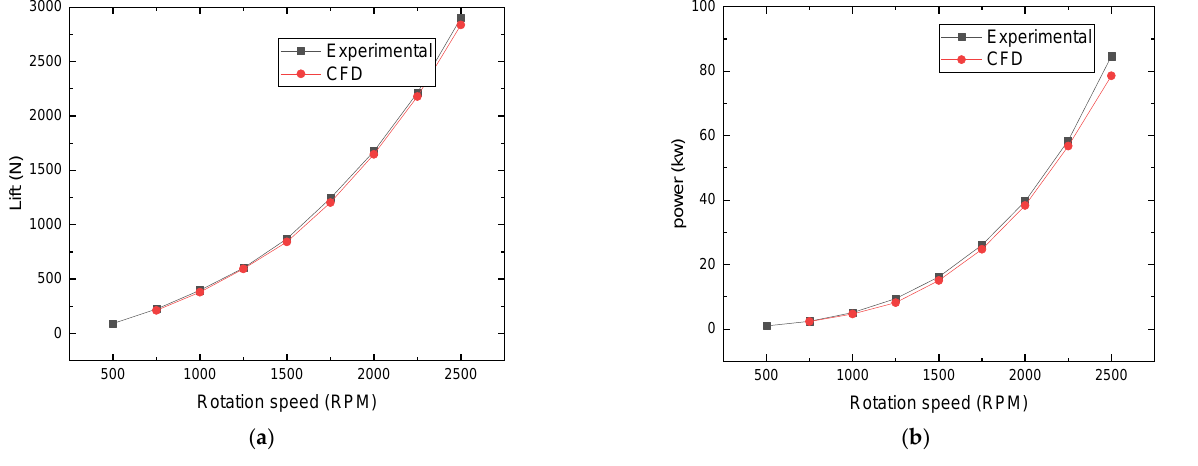
Figure 10. Comparison of CFD calculated values and experimental values: ( a ) relationship between lift and rotation speed; ( b ) relationship between power and rotation